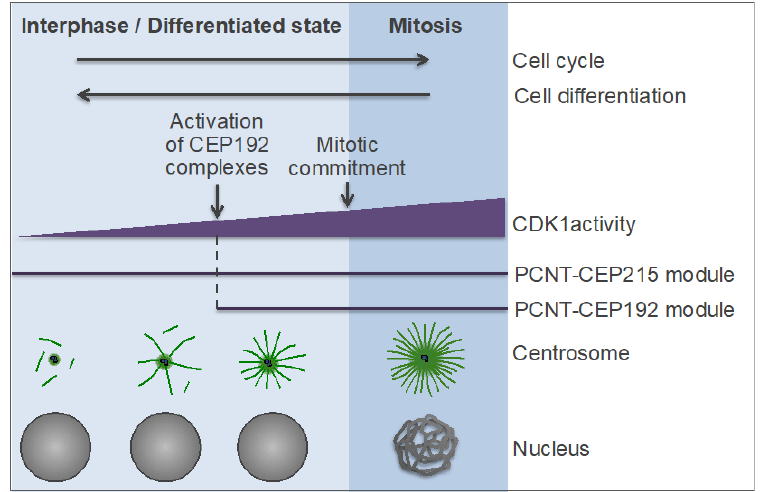
Figure 8. Hypothetical model of centrosome-driven microtubule (MT) assembly in interphase and postmitotic cells. See also Figure 5. CDK1: cyclin-dependent kinase 1; PCNT: pericentrin; CEP: centrosomal protein.